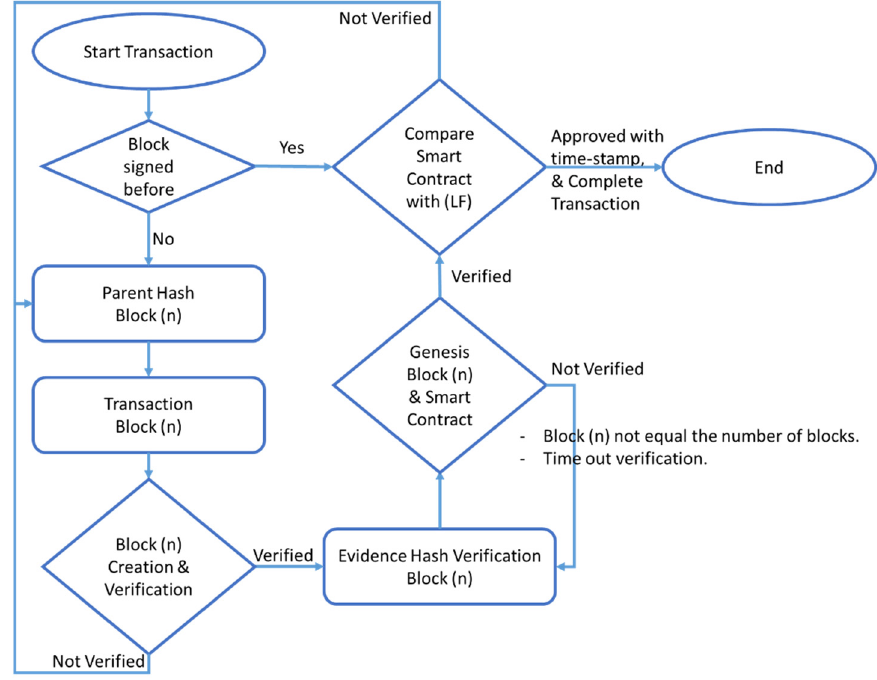
Figure 5. Flowchart of the proposed algorithm.